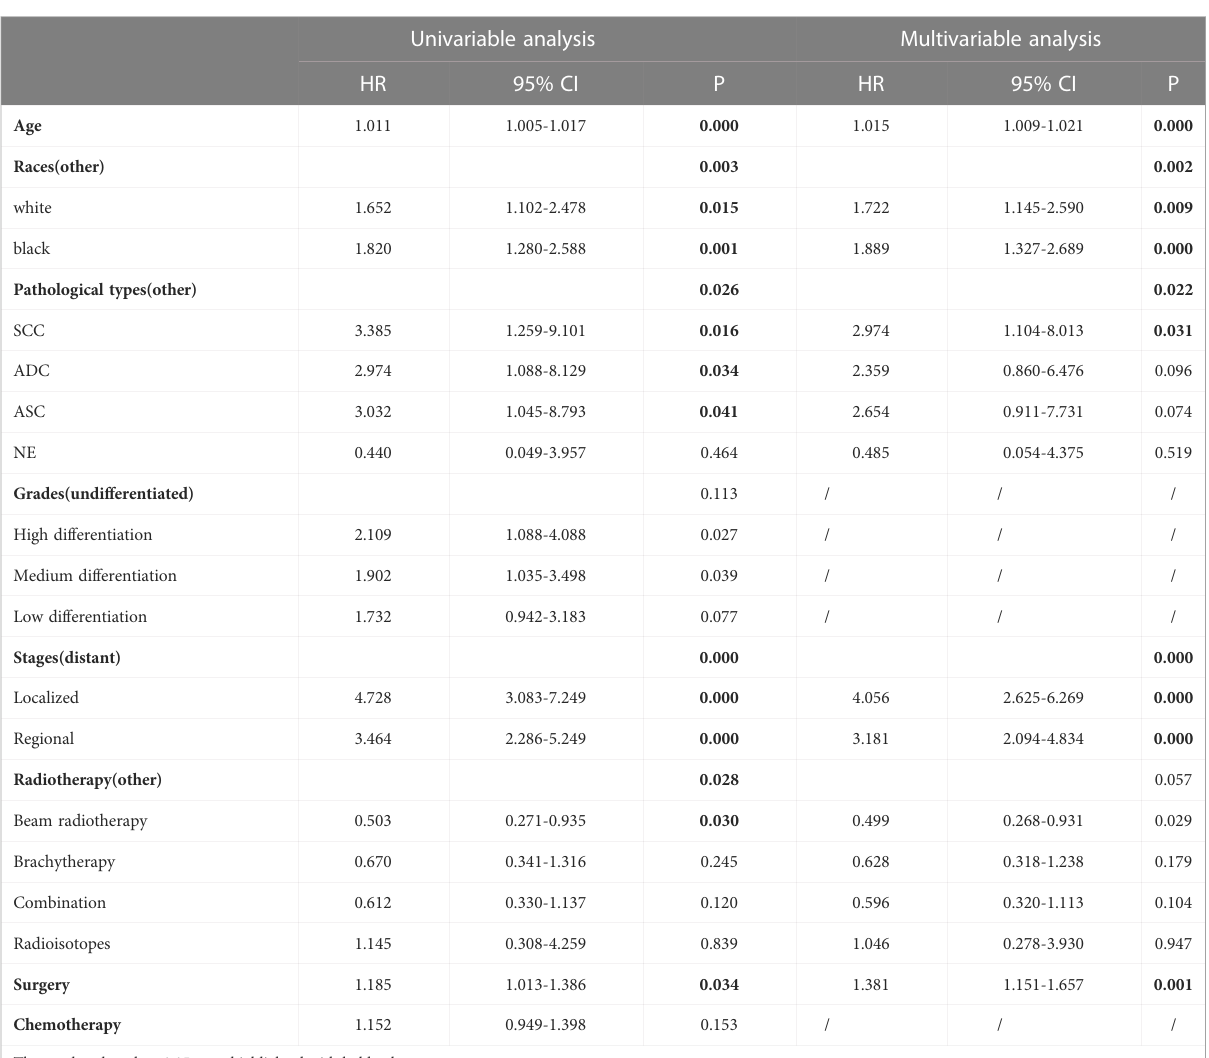
The p values less than 0.05 were highlighted with bold